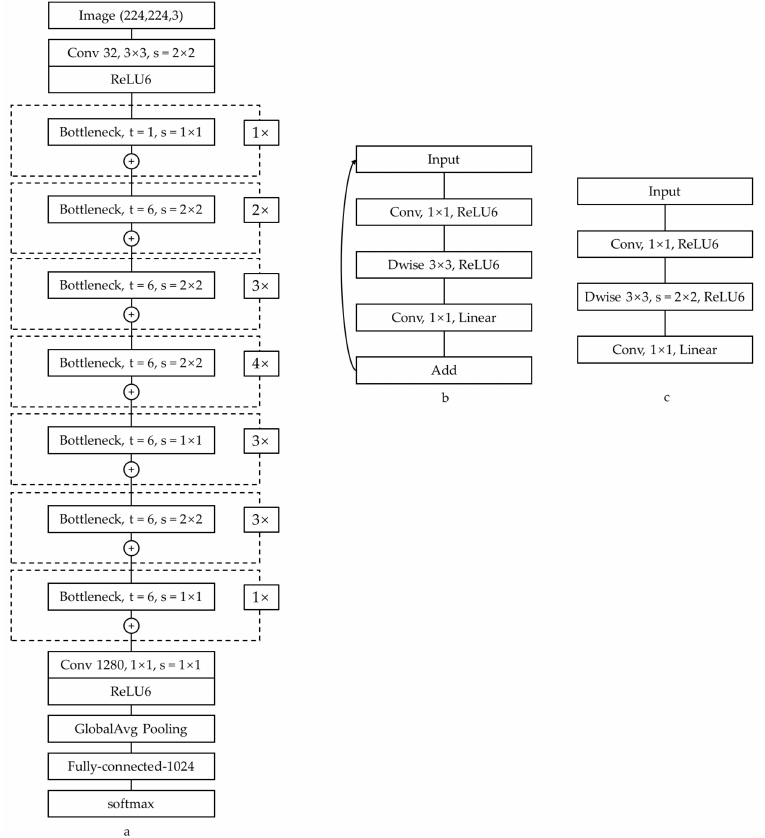
Figure 9. The MobileNetV2 architecture. Overall architecture ( a ); the residual bottleneck layer structure when s = 1 × 1 ( b ); the residual bottleneck layer structure when s = 2 × 2 ( c ).